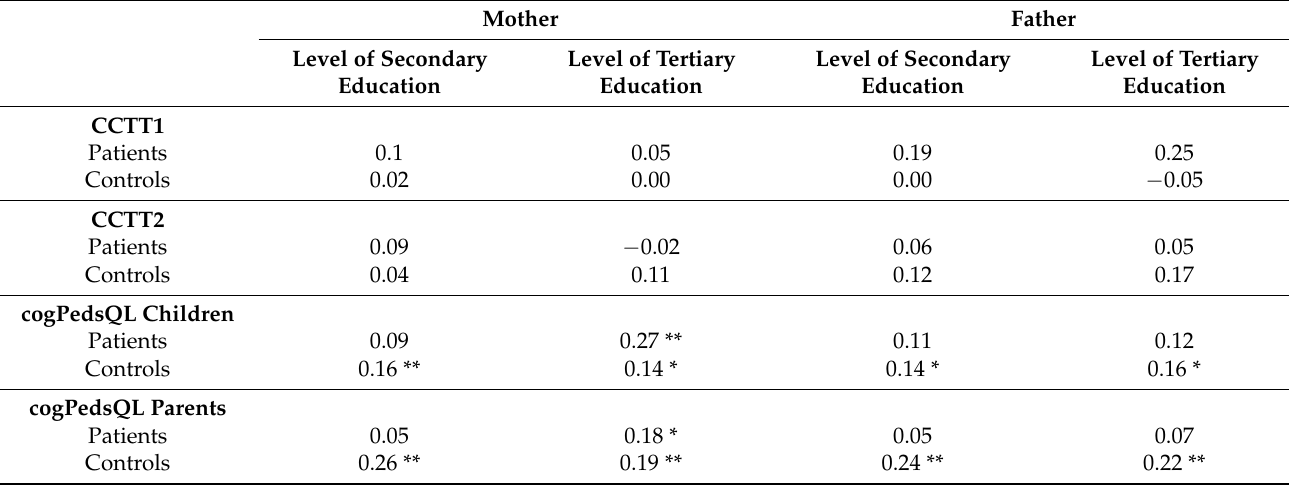
Table 5. Correlation of executive functioning and parental formal education background–Pearson’s rho correlation coefficient.